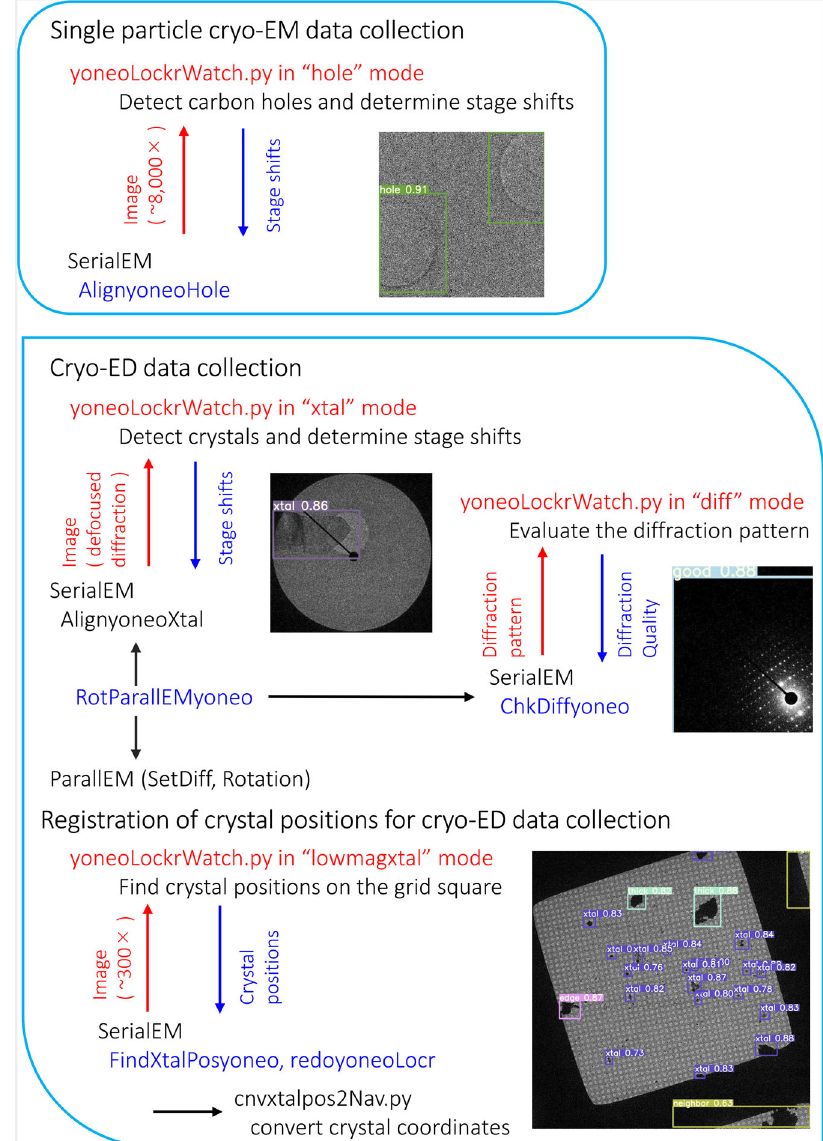
Fig. 2 Schematic diagram for positioning the target and checking the quality of diffraction patterns by yoneoLocrWatch.py, SerialEM scripts and associated programs. The main program yoneoLocrWatch.py runs in 4 distinct modes for stage alignment for a carbon hole (hole) and a crystal (xtal), for evaluation of diffraction patterns (diff) and for detection of crystals on low magni fi cation images and registration of crystal positions (lowmagxtal). The SerialEM scripts call and control yoneoLocrWatch.py and other associated programs including ParallEM.